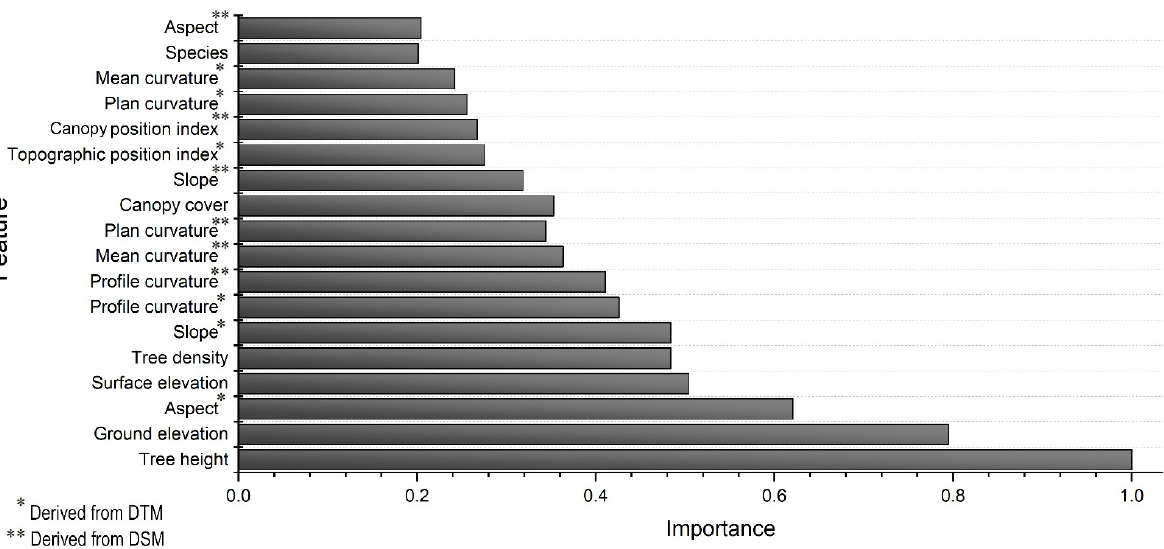
Figure 6. Importance scores of the features affecting the positioning accuracy of u-blox ZED-F9P. The top influential feature is tree height. Other features are ranked based on their importance to the tree height.